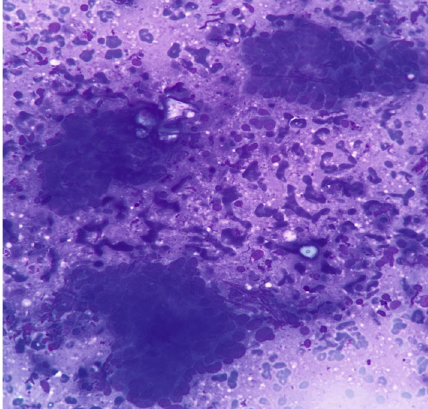
Figure 5: Cytology smear shows moderate number of isolated and clusters of highly atypical